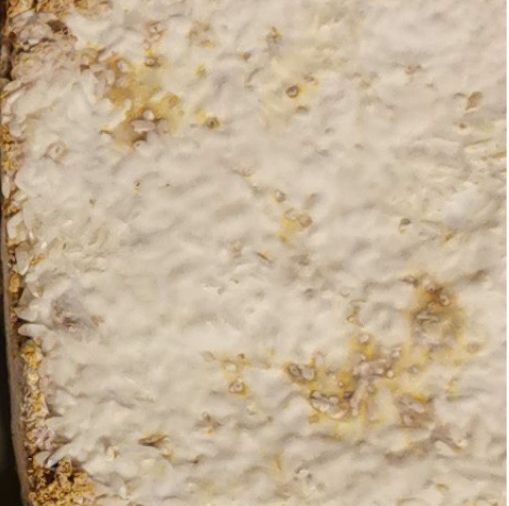
Figure 1. Sample based on hemp mix with rice. Surface: smooth, with grains of rice and substrate fibers; color: off-white, with irregularities (photo A. Bonenberg).